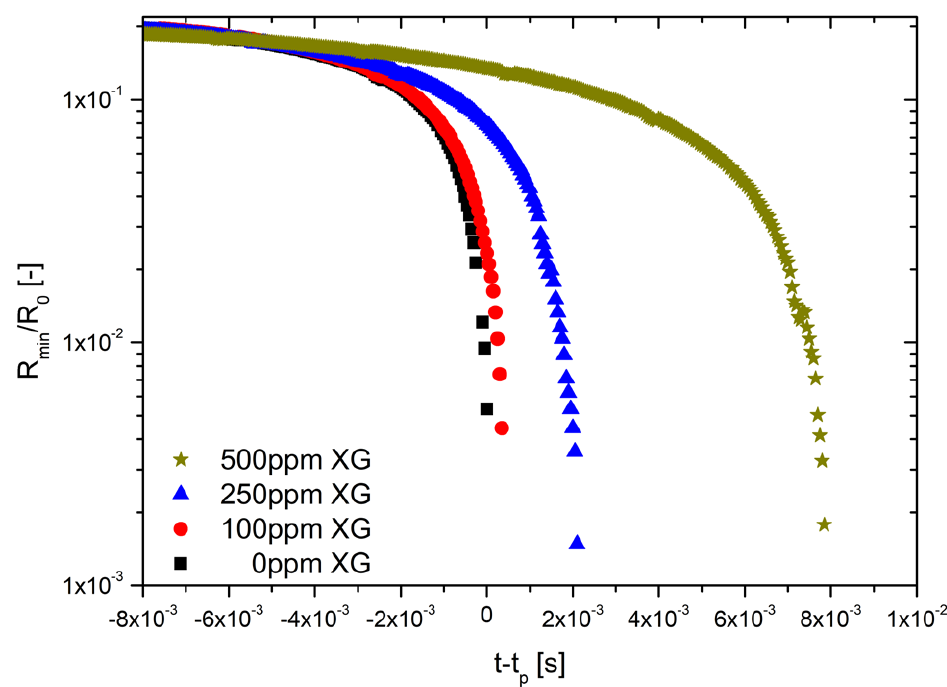
Figure 3. Effect of XG concentration on the breakup time of formulations XG0, XG100, XG250 and XG500.